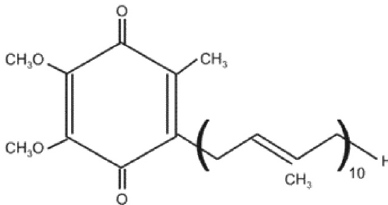
(2,3-dimethoxy-5- 10